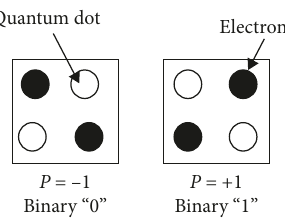
Figure 1: Two different polarizations of the quantum-dot